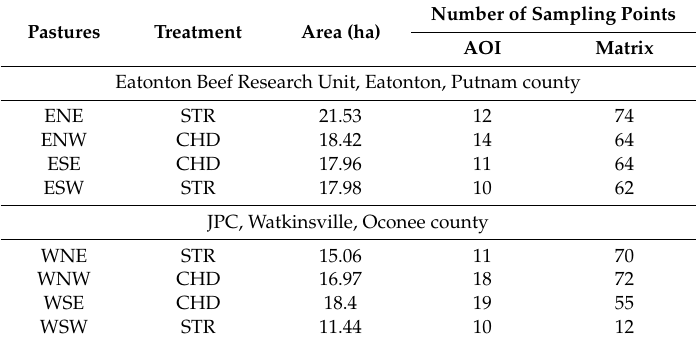
Table 1. Area and number of soil sampling points in areas of interest (AOI) and matrix (50 m grid) for pastures at Eatonton and Watkinsville locations. Pasture abbreviations indicated locations relative to each other within each research location (ENE is east northeast, ENW is east northwest, etc.). Treatments are strategic grazing (STR) or continuous-grazing-with-hay-distribution (CHD).